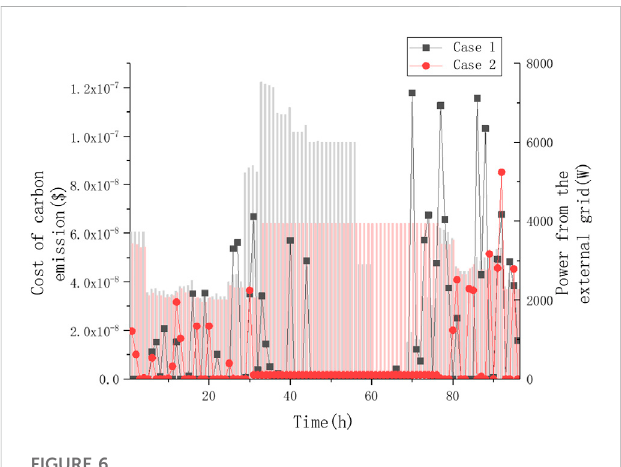
FIGURE 6 Distribution of incremental carbon emission costs in the RT